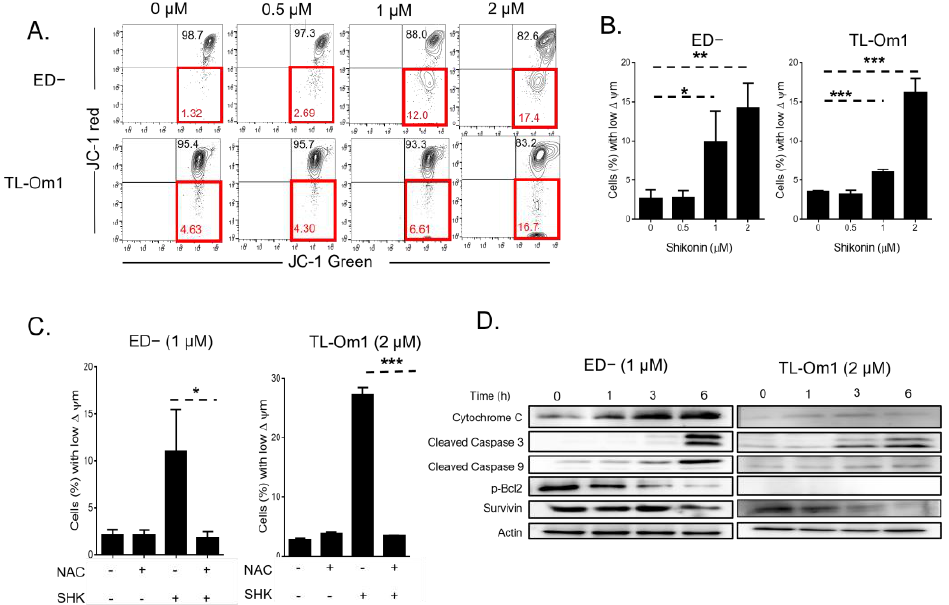
Figure 4. Induction of mitochondria depolarization through ROS with SHK treatment. ( A ) ED − and TL-Om1 cells were treated with/without SHK for 18 h (0, 0.5, 1 and 2 μM). For measurement of Δψ, cells were stained with fluorochrome dye JC-1 and analyzed by flow cytometry. Dead cells were excluded by PI staining. Green fluorescent positive cells indicated disruption of Δψ. ( B ) Bar graph represents percentage of cells with low Δψ. ( C ) ED − and TL-Om1 cells were pre-treated with or without NAC for 2 h, and subsequently treated with or without SHK (ED −: 1 μM, TL - Om1: 2 μM) for 18 h. Cells were stained by PI and measured by flow cytometry. ( D ) ED − and TL-Om1 cells were treated with/without SHK (ED −: 1 μM, TL - Om1: 2 μM) for 0, 1, 3 or 6 h. Mitochondria depolarization and apoptosis markers were determined using Western blotting. *p<0.05, **p<0.01, ***p<0.001.